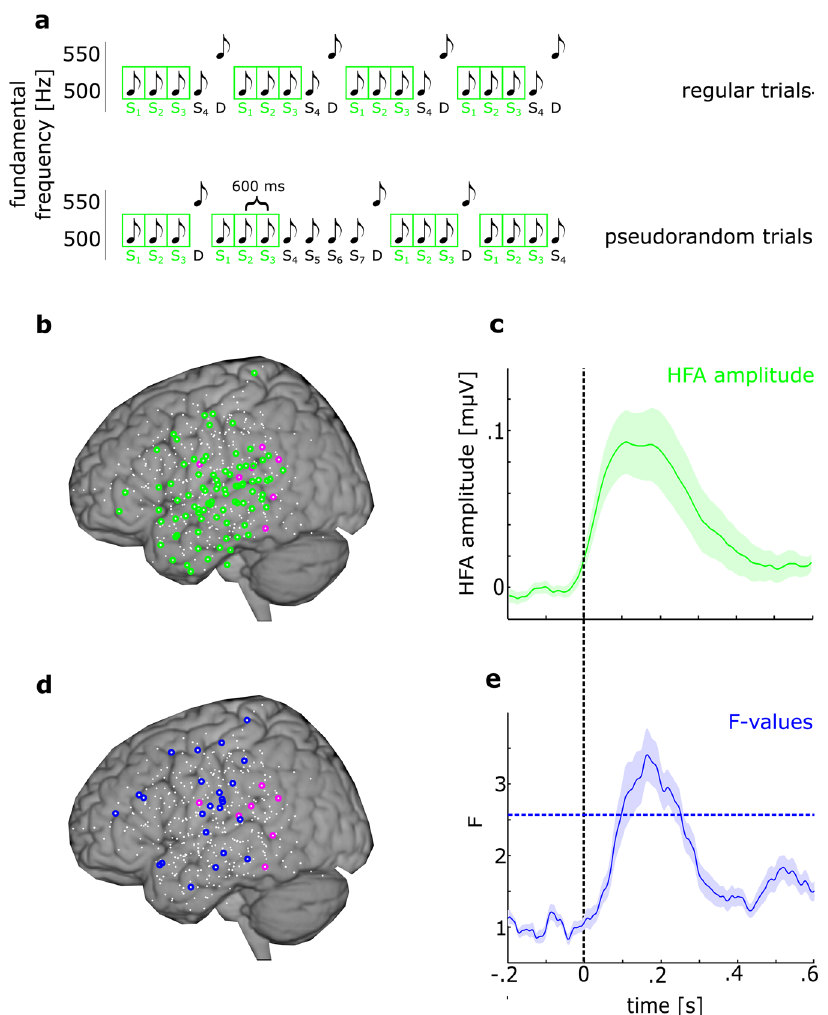
Fig. 1 Stimulus response and repetition suppression show different spatial pro fi les. a shows the auditory oddball paradigm. While the occurrence of deviants was unpredictable, S 1 , S 2 , and S 3 were always predictable. b shows the spatial distribution of HFA SR + RS – (green) and SR + RS + (magenta) channels as marked dots against the background of a standard schematic brain using MNI coordinates that was also used for surgical planning. The remaining electrodes are marked by small white dots. c shows the HFA amplitude modulation of SR + channels over time averaged across electrodes. The shaded area denotes the standard error across channels. d shows the spatial distribution of HFA SR – RS + channels (blue) analog to b . Channels with magenta circles represent SR + RS + , as in b . e Modulation of repetition-suppression ( F values) in SR – RS + channels. The dashed blue line represents the signi fi cance threshold of F values. The shaded area denotes the standard error across the channels.